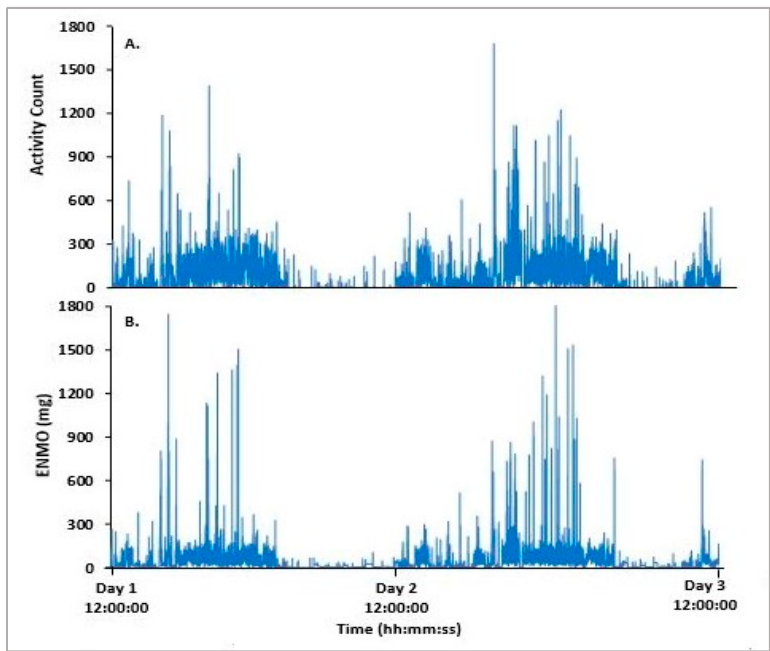
Figure 2. Representative epoch-by-epoch activity tracing of Actiwatch 2 (top) and Verisense (bot- tom) from a participant over a 48 h FL study.